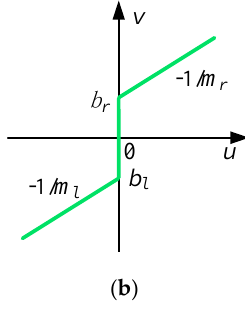
Figure 2. Dead-zone and dead-zone inverse: ( a ) dead-zone; ( b ) dead-zone inverse.